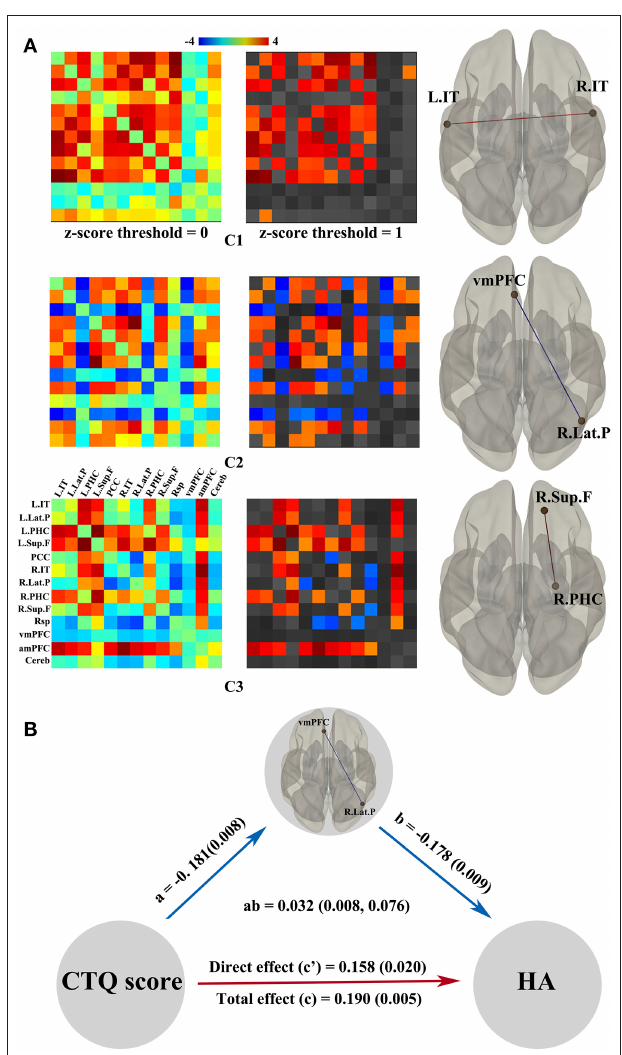
FIGURE 3 | Dynamic functional properties of DMN related to the CTQ score and significant mediation effects in the environment-brain-behavior pathway. (A) shows three independent spatial components best characterizing the observed connectivity-modulation across time. Regression analyses showed connections that significantly correlated with the CTQ score in each component. The red line represents positive correlations while the blue line represents negative correlations. Only the vmPFC-R.Lat.P connectivity was found as a significant mediator between the CTQ score and HA score (B) . There were significant positive effects from the CTQ score to HA score, a negative effect from the CTQ score to vmPFC-R.Lat.P connectivity, and a negative effect from the vmPFC-R.Lat.P connectivity to HA score. CTQ, Childhood Trauma Questionnaire; DMN, default mode network; HA, harm avoidance; L.IT, left inferior temporal cortex; R.IT, right inferior temporal cortex; R.Lat.P, right lateral parietal cortex; R.PHC, right parahippocampal gyrus; R.Sup.F, right superior frontal cortex; vmPFC, ventral medial prefrontal